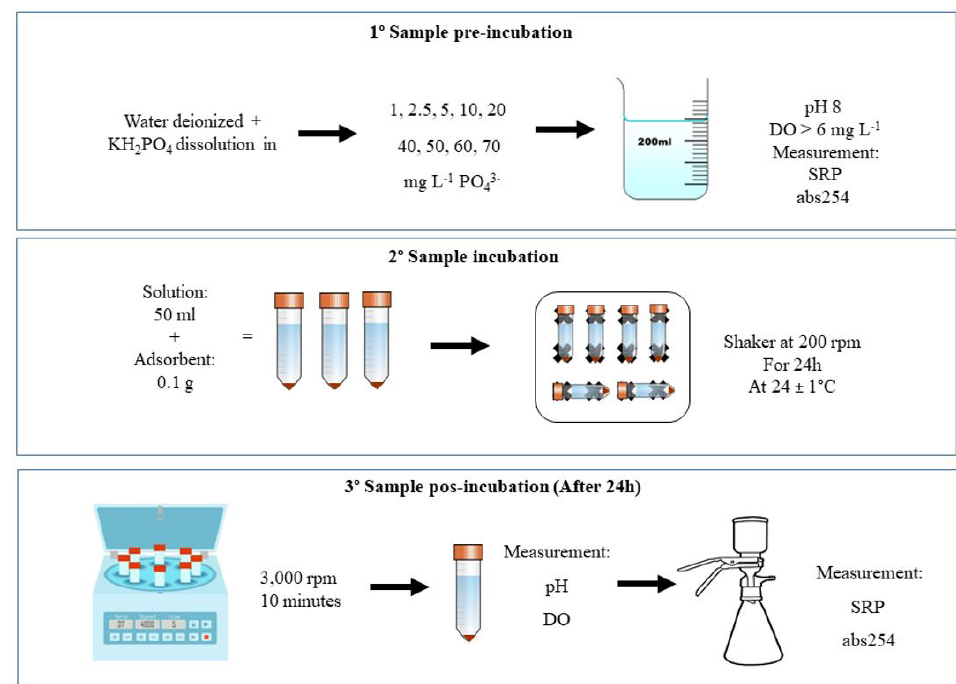
Figure 1. Experimental design of adsorption tests. DO= Dissolved oxygen; SRP= Reactive Soluble